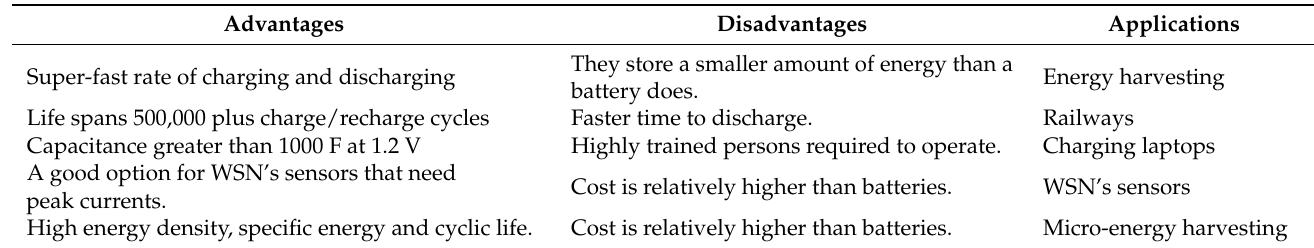
Table 5. Advantages, disadvantages and applications of super/ultra-capacitors.